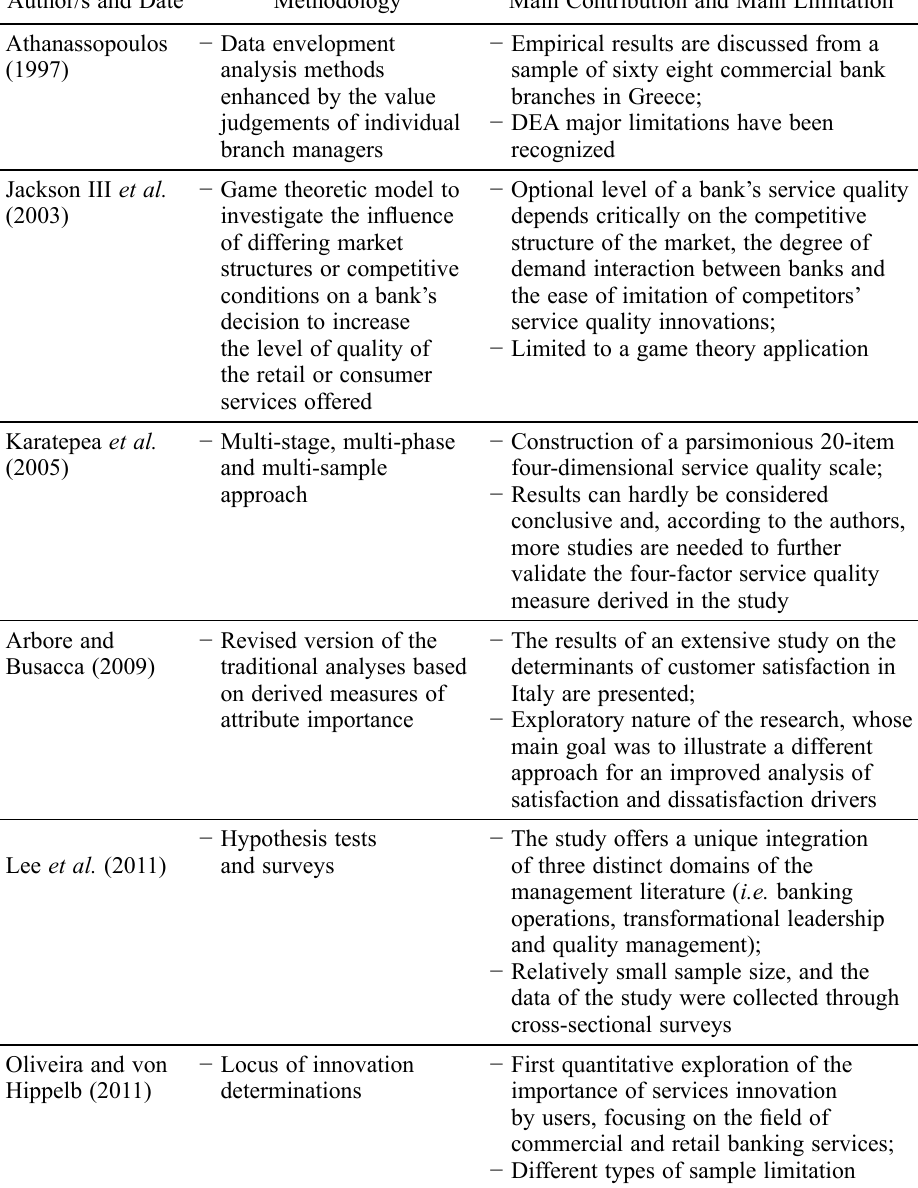
Table 1. Previous work on bank branch service quality and